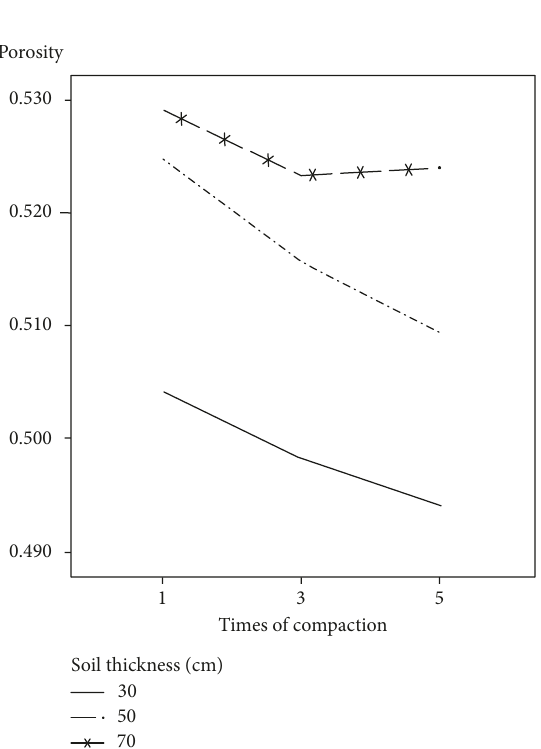
Figure 6: Change of the porosity of different topsoil thickness to times of